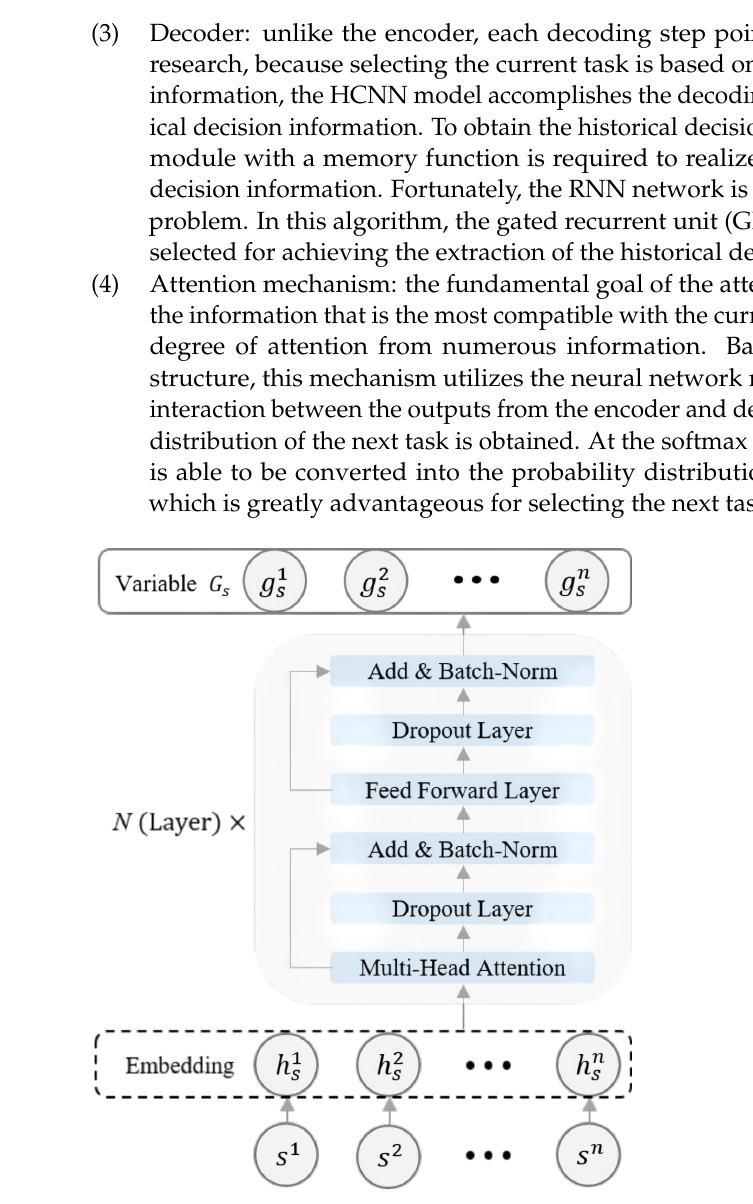
Figure 4. Structure of multi-head